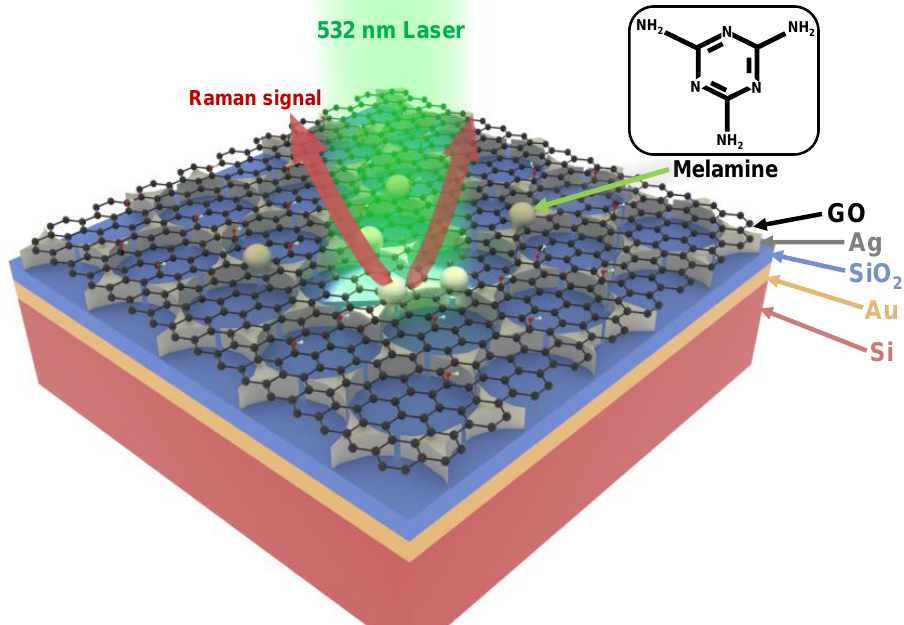
Figure 1. Schematic illustration of trace melamine measurement using the GO/Ag/SiO 2 /Au/Si SERS substrate. The gray spheres represent the melamine molecules. The right top illustrates the molecular structure of melamine.